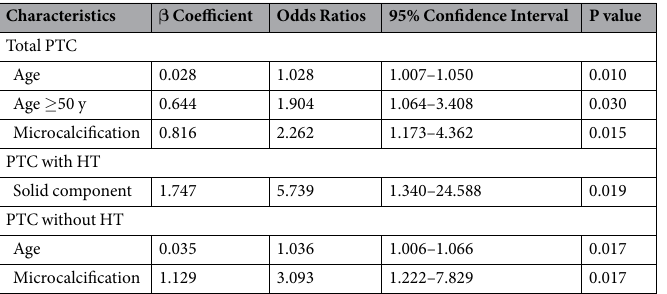
Characteristics